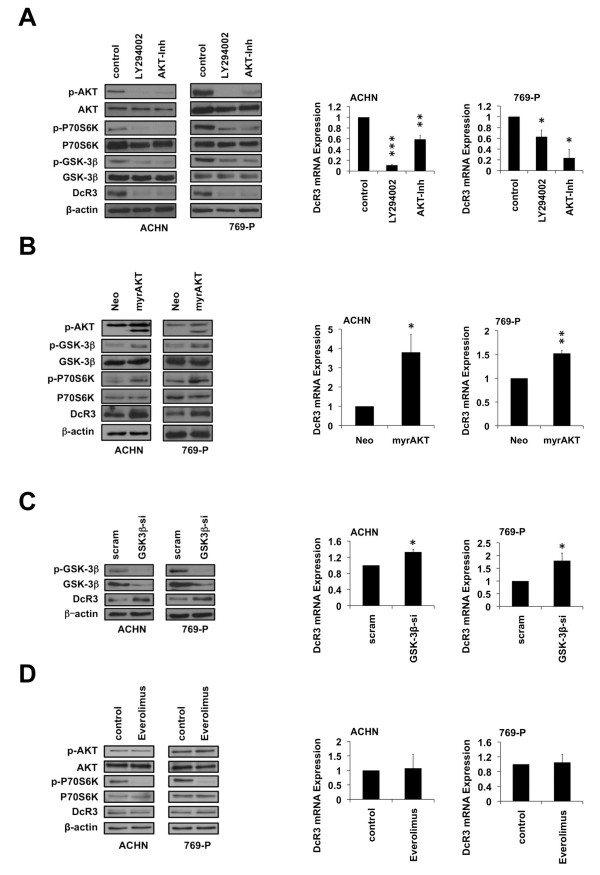
DcR3 expression in RCC is PI3K/AKT-dependent. (A-D) Immunoblot analysis of whole-cell lysates and quantitative real-time-PCR assaying relative DcR3 mRNA expression of ACHN and 769-P cells 24 h after treatment with LY294002 (50 μM) or AKT-inhibitor IV (10 μM) (A); 48 h post transfection with constitutively active AKT (myrAKT) or an empty vector control (neo) (B); 48 h post transfection with GSK-3β-specific siRNAs or a non-specific siRNA (scram) (C); 24 h after treatment with Everolimus (1 μM) (D). Expression data were normalized to internal 18S rRNA expression (mean ± SEM; n=3; *p<0.05, **p<0.01, ***p<0.001; T-test).